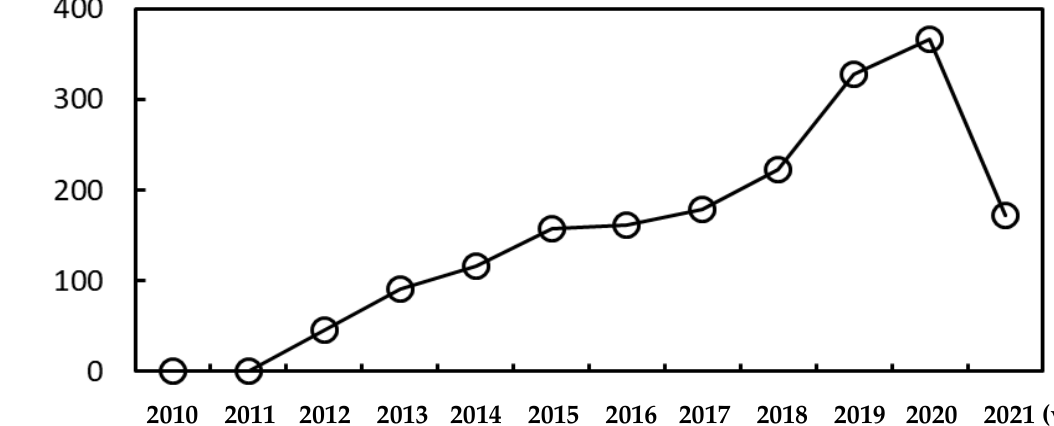
Figure 1. The number of citation of research articles under the topic of protein corona studied by molecular dynamics simulations as of April/2021.